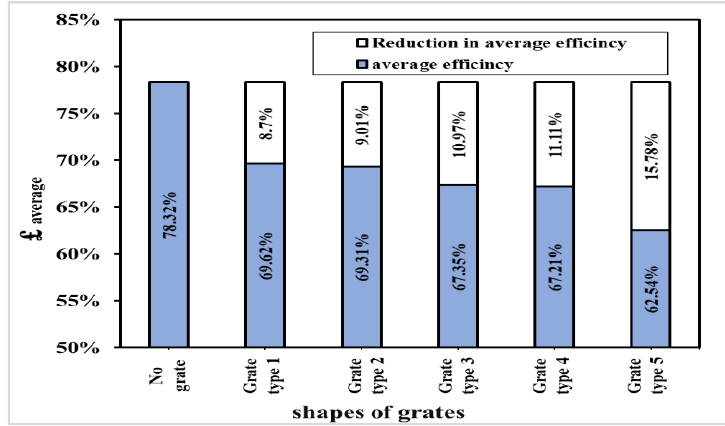
Figure 8. The average discharge efficiency for different types of grate shapes.